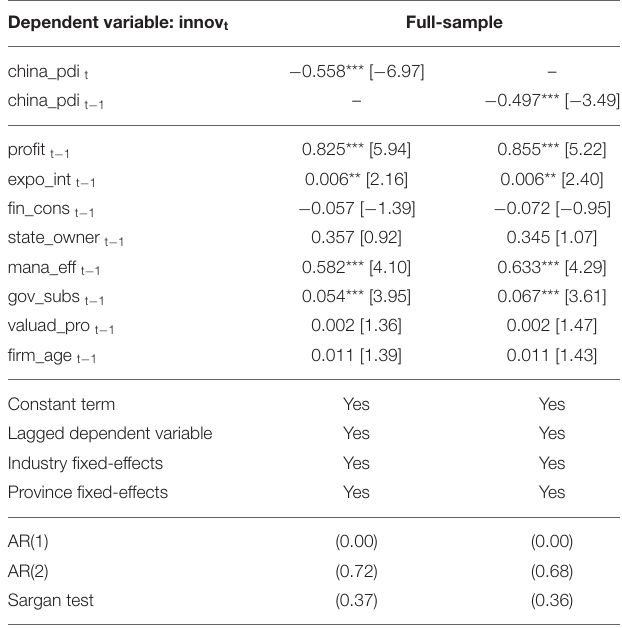
TABLE 5 | Results of the Blundell–Bond estimations (current controls). TABLE 6 | Results of the Blundell–Bond estimations (lagged